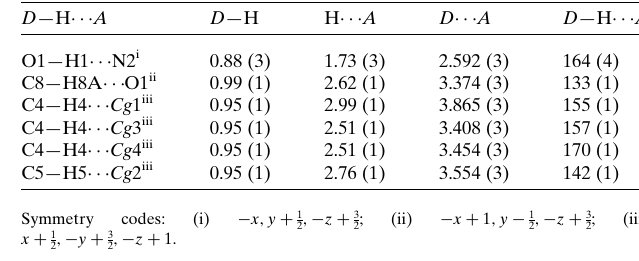
Table 1 Hydrogen-bond geometry (A˚ , (cid:2) ).